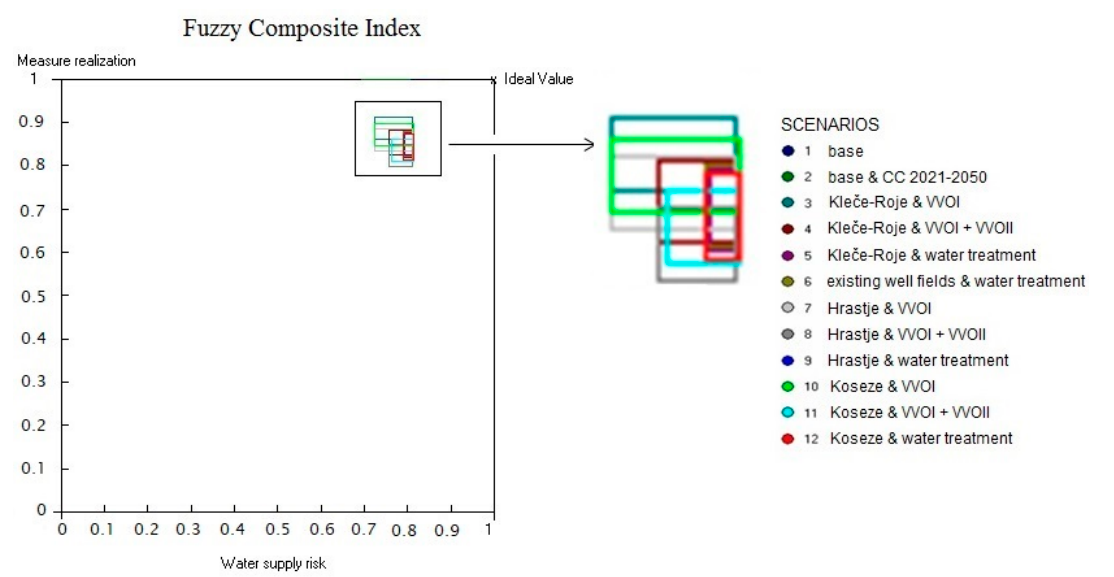
Figure 4. Ranking of the management actions according to the ranking criteria for the Ljubljana Field aquifer (case 1: measure realization parameter flexibility is set to 1 for all options; weights for groundwater availability parameters and water contamination risk parameters are 1).